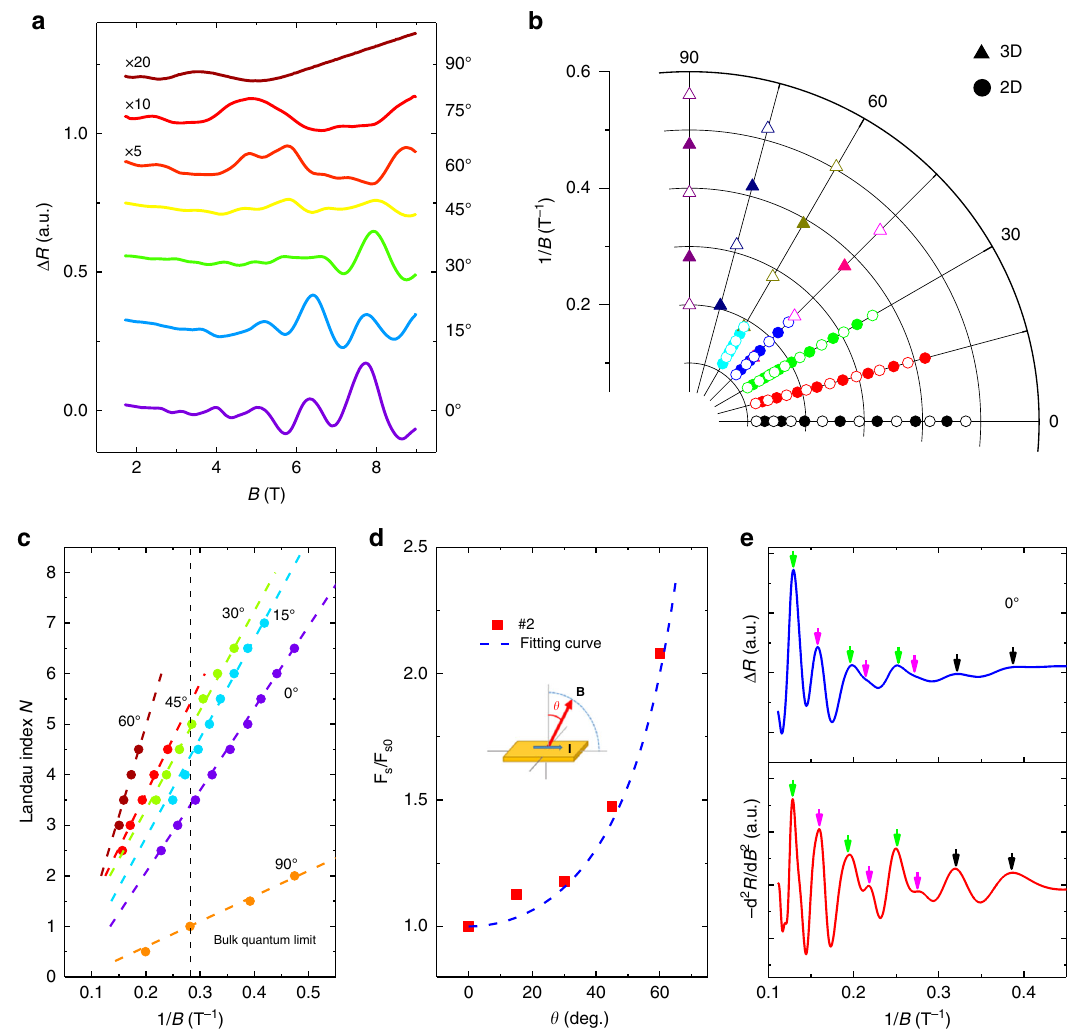
Fig. 2 SdH oscillations in Cd 3 As 2 nanoplate with low-Fermi-level. a , b The extracted SdH oscillations of sample #2 at different angles a and LL spectrum b . c Landau fan diagram in the low fi eld regime. d The angle dependence of normalized oscillation frequency ratio. F s denotes the 2D oscillation frequency and F θ = 0°. The inset is a sketch of the magnetotransport geometry. e Comparison of Δ R and (cid:1) d 2 R s0 represents the 2D oscillation frequency at extra hidden peaks are revealed by (cid:1) d 2 R while being less obvious in the Δ R d B 2